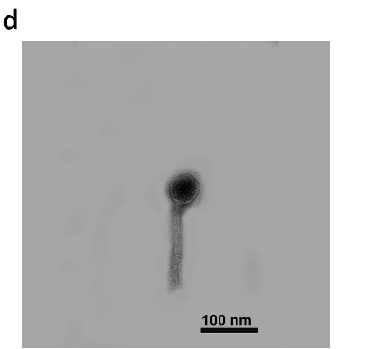
Figure 1. Virions and plaque morphology of phages BF9, BF15, and BF17. Upper panels ( a – c ) represent plaques of BF9 ( a ), BF15 ( b ), and BF17 ( c ) formed in double-layer agar plates with respective host strains. Lower panels ( d – f ) represent TEM micrographs of phages BF9 ( d ), BF15 ( e ), and BF17 ( f ).